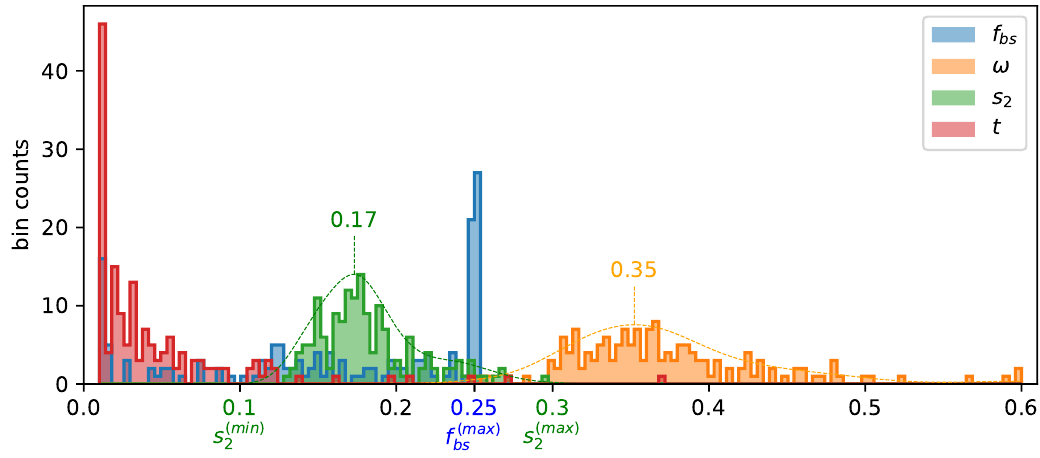
Figure 12. Histogram of the resulting parameter-values. (Lower and upper bounds used in the retrieval-procedure that deviate from 0. and 0.6 are indicated